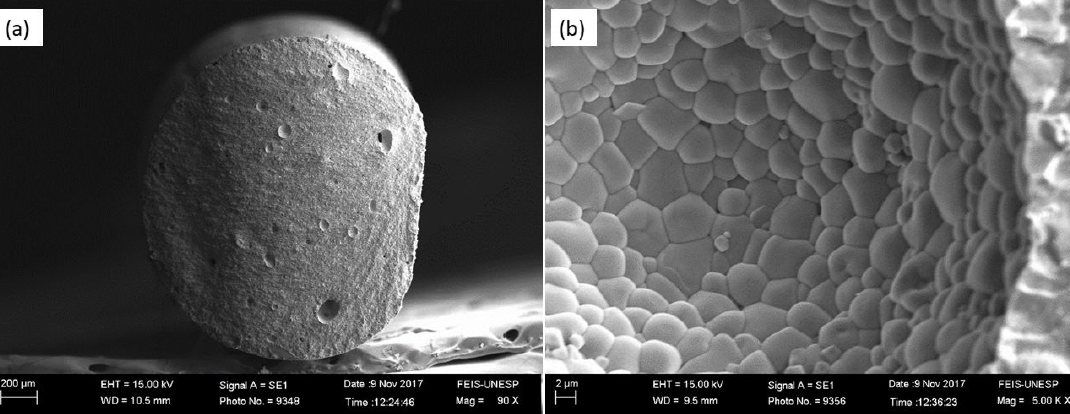
Figure 3. Morphological analysis of PZT rods after calcination and